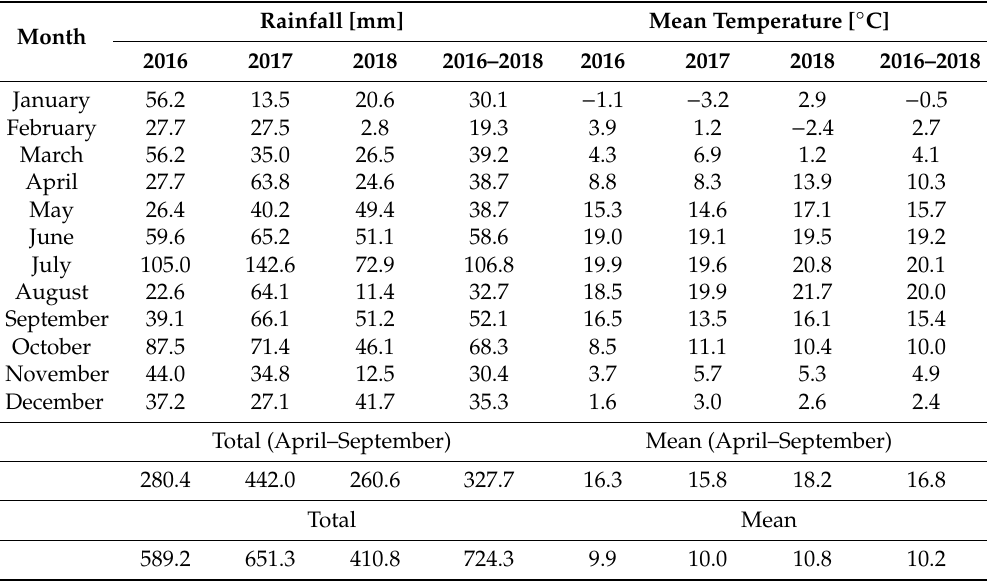
Table 2. Monthly precipitation and average daily air